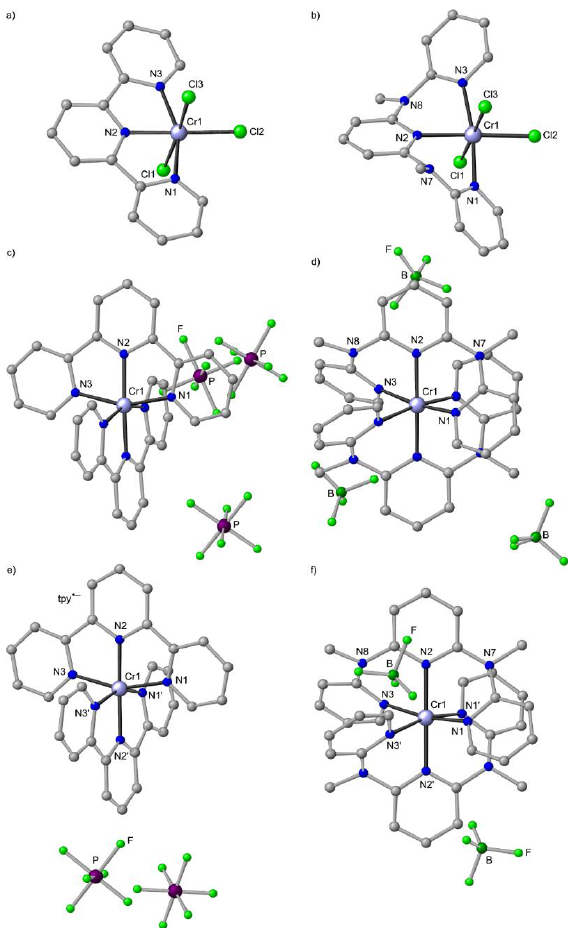
Figure 9. Molecular structures of ( a ) CrCl 3 (tpy) × DMSO [127], ( b ) mer -CrCl 3 (ddpd) [126], ( c ) [Cr(tpy) 2 ][PF 6 ] 3 × 2.5CH 3 CN [126], ( d ) mer -[Cr(ddpd) 2 ][BF 4 ] 3 × 3CH 3 CN [50] and ( e ) [Cr(tpy) 2 ][PF 6 ] 2 × 2CH 3 CN [27] and ( f ) mer -[Cr(ddpd) 2 ][BF 4 ] 2 × 2CH 3 CN in the solid state; hydrogen atoms and solvent molecules omitted. Atom numbering unified for clarity. In the dications two different tridentate ligands are observed labelled as N1/N2/N3 and N1 ′ /N2 ′ /N3 ′ . The room temperature magnetic susceptibility of [Cr(tpy) 2 ] 3+ and [Cr(ddpd) 2 ] 3+ amounts to T = 1.921 and 1.838 cm 3 K mol – 1 , respectively (Table 5), confirming the expected (t 2g ) 3 electron configuration ( 4 A 2 ground state) for both complexes [27,50]. The magnetic moment of [Cr(ddpd) 2 ][BF 4 ] 3 is temperature-independent down to 40 K. At 2 K, T has dropped to 1.788 cm 3 K mol − 1 , suggesting weak zero-field splitting or weak intermolecular antiferromagetic interactions. The first spin-allowed ligand field transition 4 A 2 → 4 T 2 of [Cr(tpy) 2 ] 3+ appears at 533 nm [126], that of [Cr(ddpd) 2 ] 3+ at 435 nm [50]. These data imply a much larger ligand field splitting ∆ o in the latter complex by more than 4200 cm − 1 . The non-innocent tpy ligand accounts for the ligand-based reduction chemistry of [Cr III (tpy) 2 ] 3+ giving [Cr III (tpy · − )(tpy)] 2+ , [Cr III (tpy · − ) 2 ] + and [Cr III (tpy 2 − )(tpy · − )] 0 , respectively, as demonstrated by Wieghardt and co-workers [27]. On the other hand, [Cr(ddpd) 2 ] 3+ is reversibly reduced to the reactive d 4 chromium(II) complex [Cr(ddpd) 2 ] 2+ at − 1.11 V and irreversibly at the ddpd ligand at − 1.94 V (Table 4) [50]. The ddpd/ddpd · + oxidation is observed at +1.71 V, at much higher potential than the oxidation of the ddpd ligand in the dicationic [Zn(tpy) 2 ] 2+ complex (+1.17 V, Table 4) due to the +3 charge of